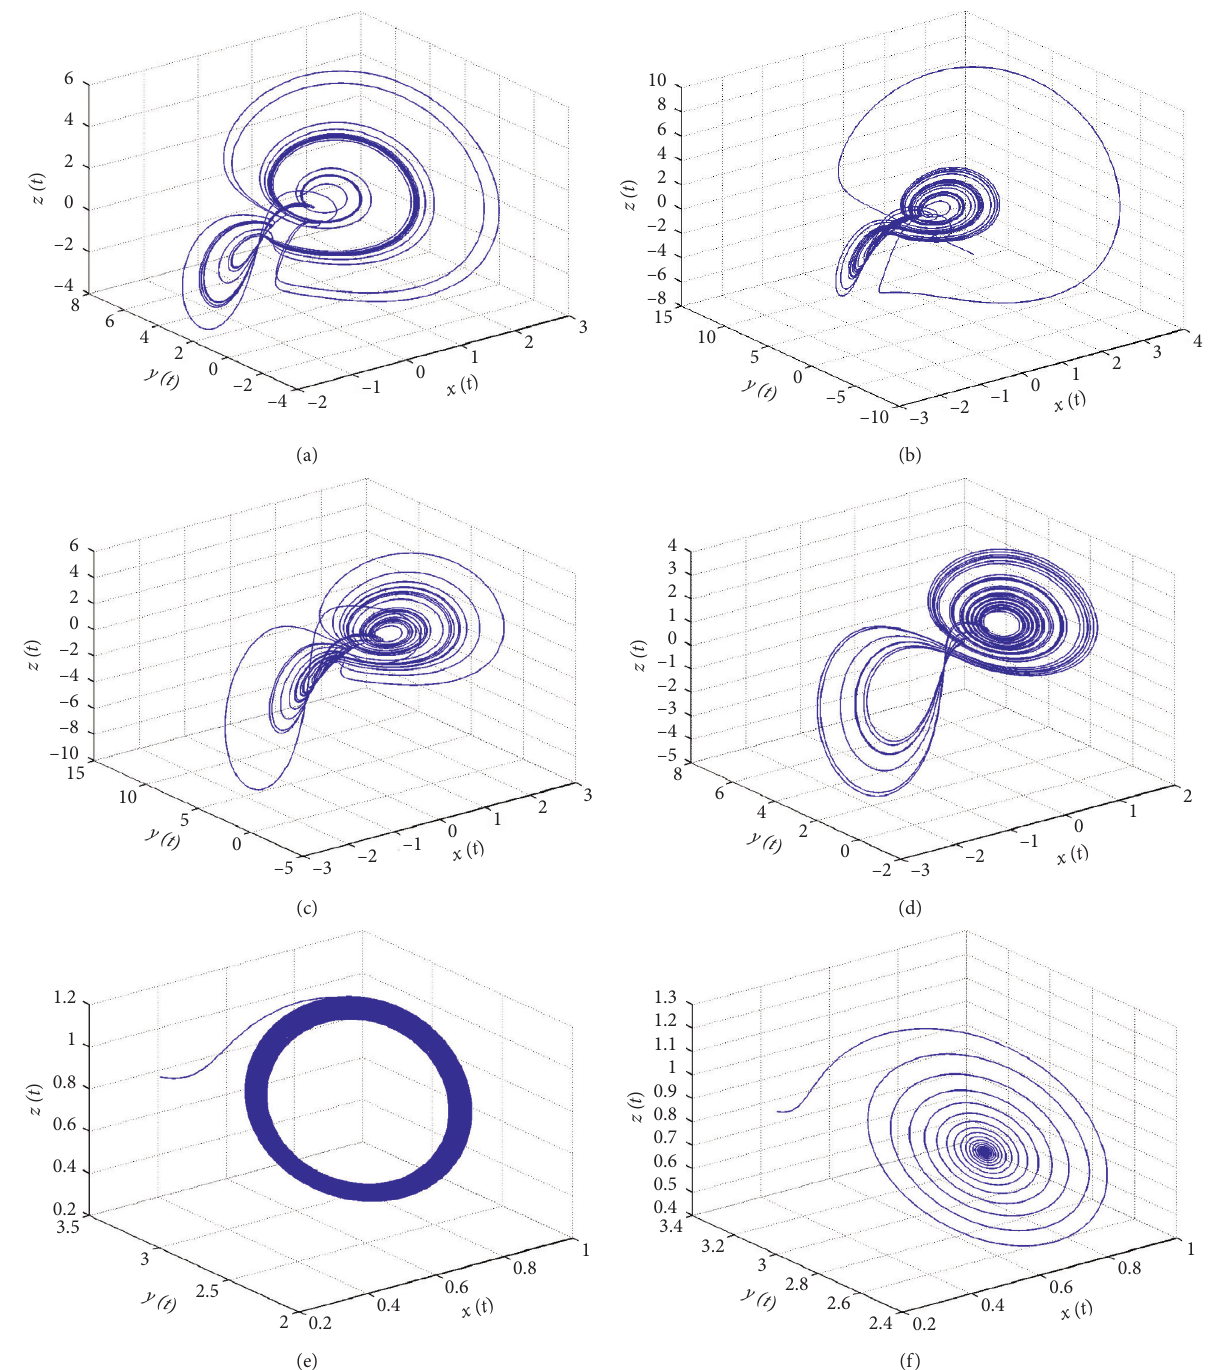
Figure 1: 3D plots of FOS model (20) with a � 0 . 4 , b � 0 . 175 , and c � 0 . 4 showing that (a) chaos exists at α � 0 . 99;(b) chaos exists at α � 0 . 97; (c) chaos exists at α � 0 . 95; (d) chaos exists at α � 0 . 93; (e) quasi-periodic attractor exists at α � 0 . 92; (f) asymptotic attractor exists at α � 0 .